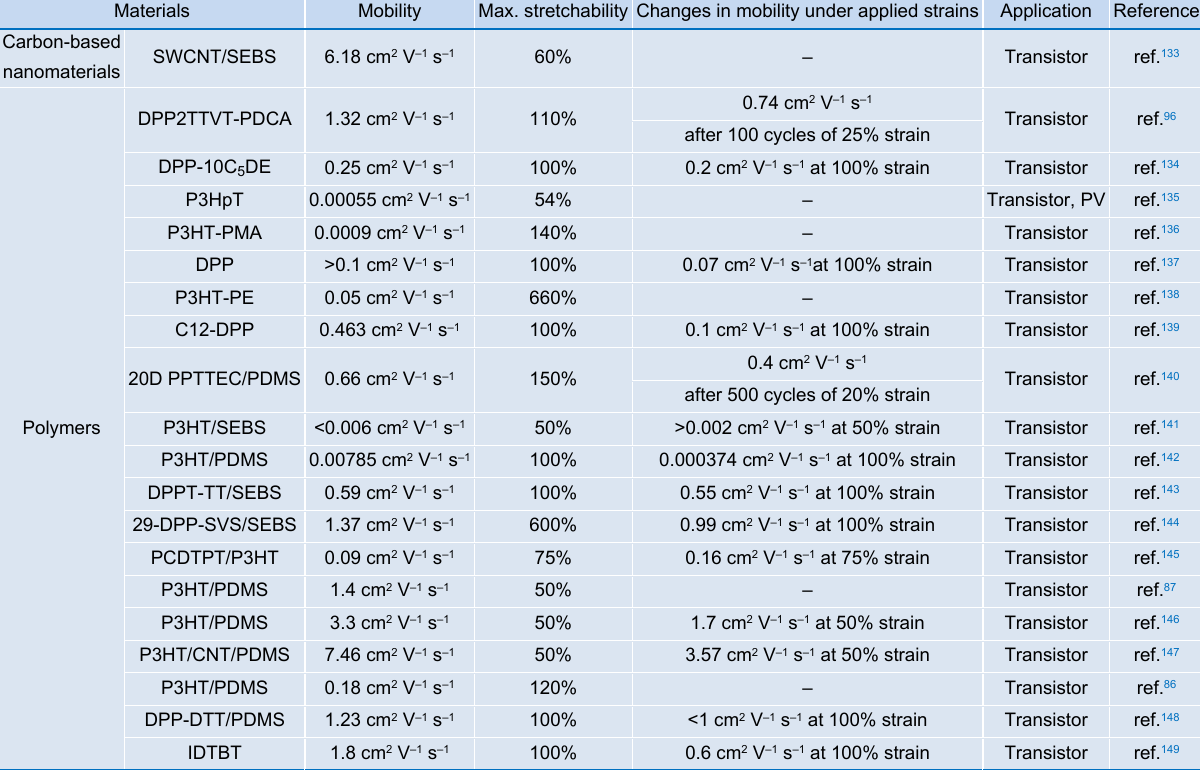
Table 2 | Electrical/mechanical performances of intrinsically stretchable semiconducting materials. Materials